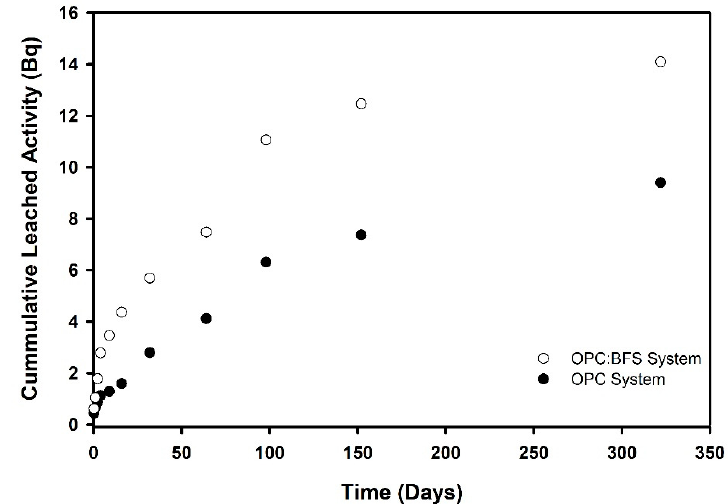
Figure 4. Release of 239 Pu from cement samples over time. Samples are 100% OPC and 3:1 BFS:OPC. For comparison, this figure is shown as cumulative leached activity vs Materials Figure Table 2. Initial and long-term leach rates of 239 Pu from cement samples.